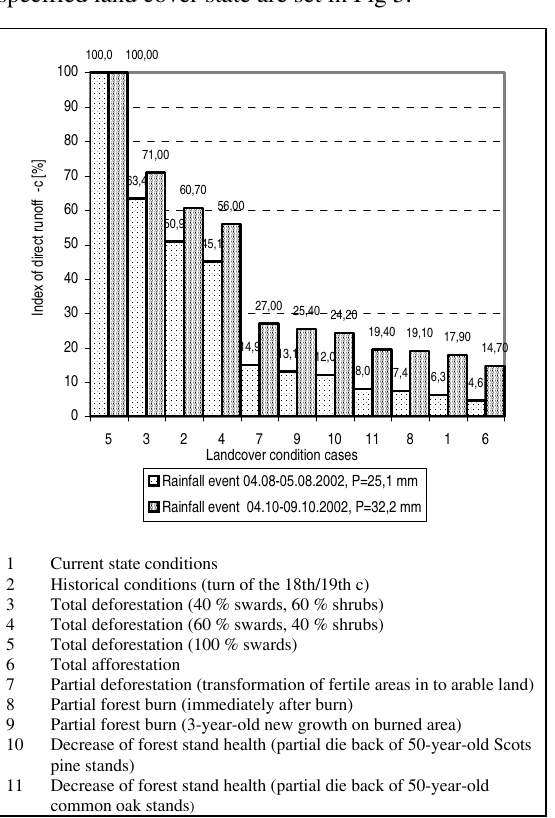
Fig 5 . Index of direct runoff of Trojanka catchment